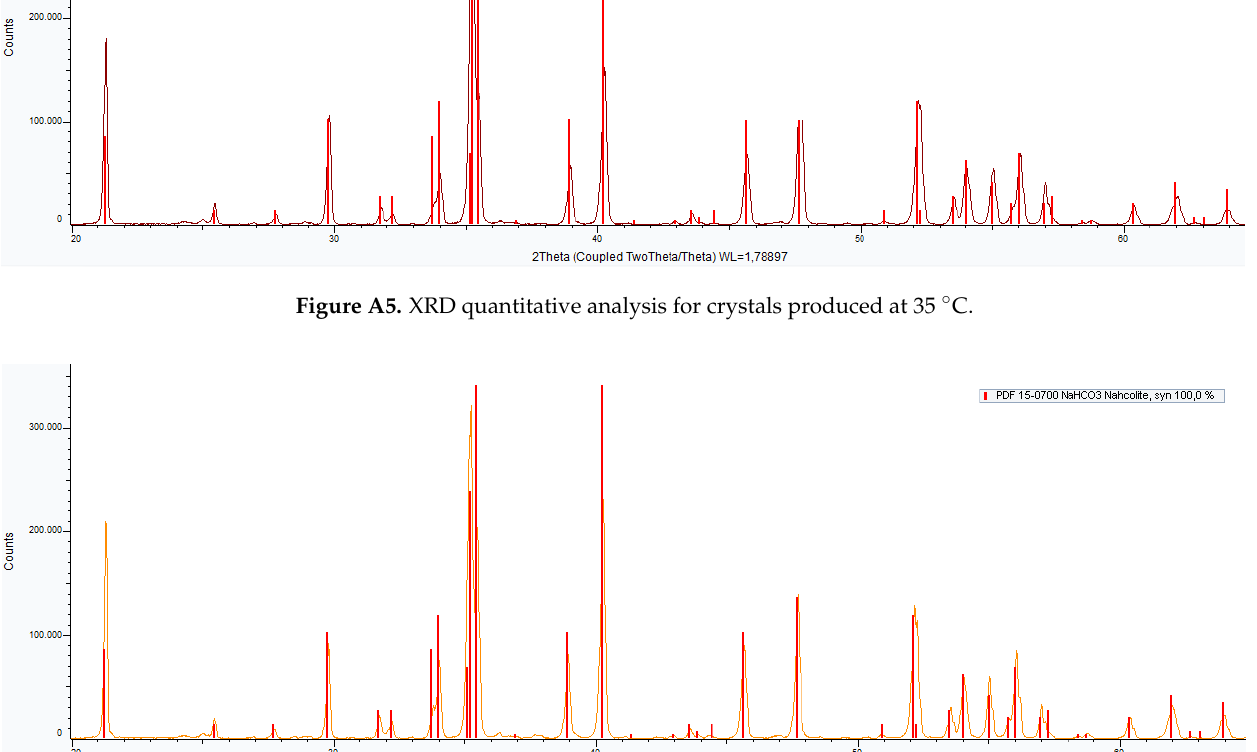
Figure B5. XRD quantitative analysis for crystals produced at 40 °C.